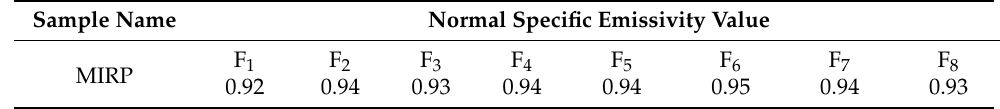
Table 3. The infrared emissivity and wavelength.